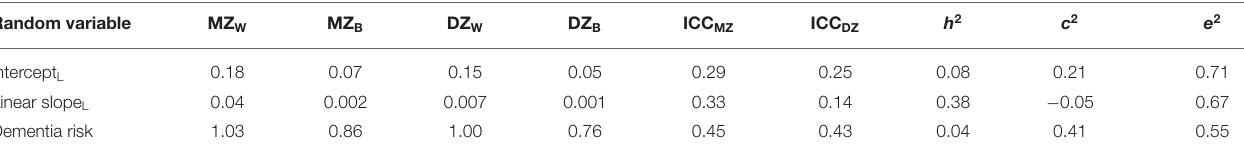
TABLE 2 | MZ and DZ variance components, intraclass correlations, and univariate genetic and environmental estimates for loneliness growth parameters and dementia risk. Random